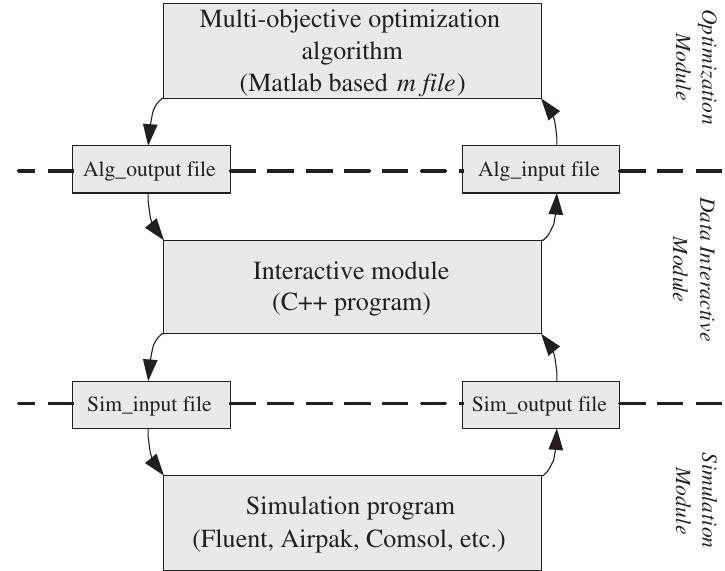
Figure 1. The basic optimization frame based on data interactive